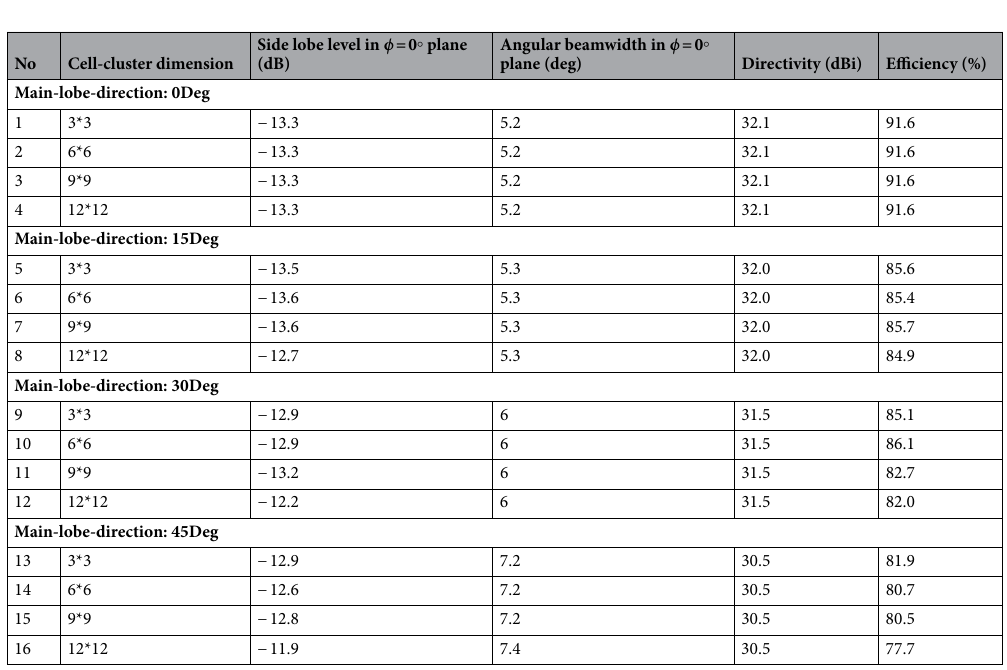
Table 1. Radiation characteristics of the proposed antenna for different values of cell-cluster dimensions.